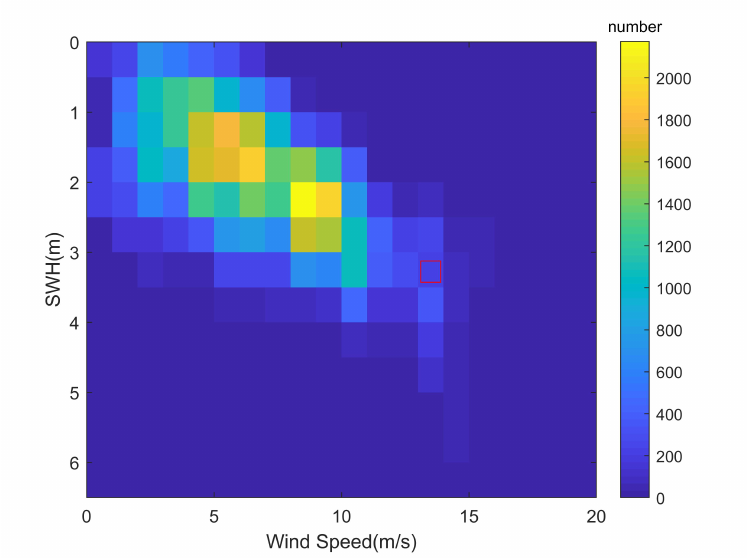
Figure 17. Wind speed–SWH distribution of the training data